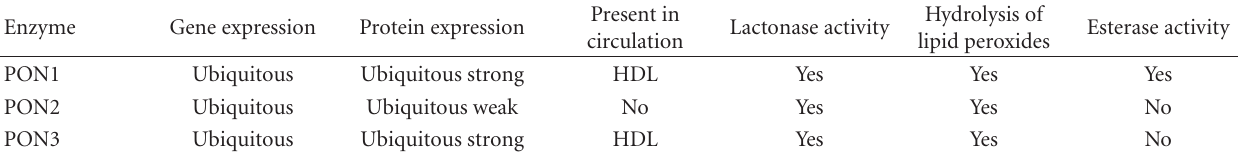
Table 1: Principal properties of the PON